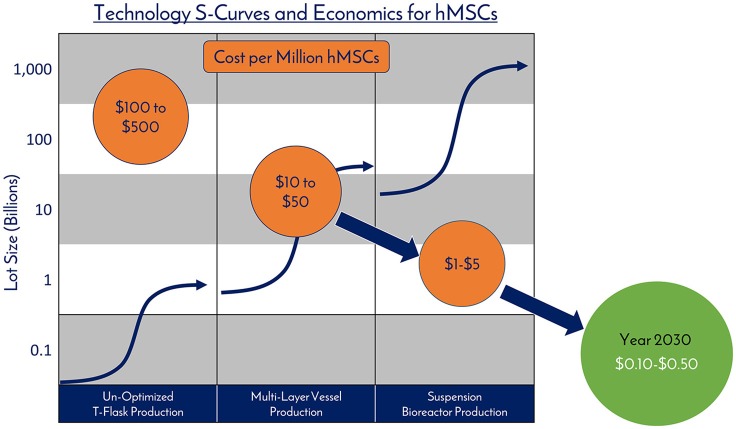
Technology S-Curves and economics for hMSCs. hMSC production processes follow technology development S-Curves as they are adopted and integrated into products and processes. In general, a new hMSC production technology or method is developed, then achieves widespread adoption as a production platform and becomes a standard. This translates to a decrease in the total cost per cell produced due to efficiencies of scale. However, there are diminishing returns as larger scales are required and productivity plateaus until pioneering developments provide a breakthrough another production technology.